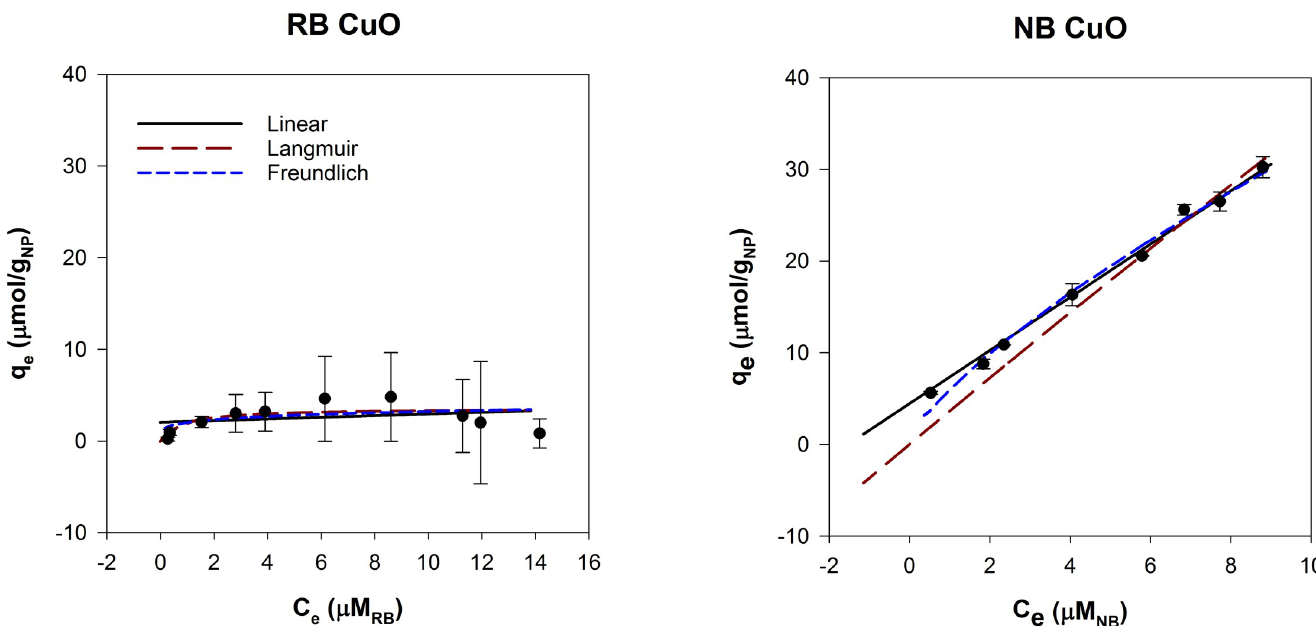
Fig 4. Adsorption isotherms for 250 mg/L CuO with Rose Bengal and Nile Blue modeled with linear, Langmuir and Freundlich adsorption models.